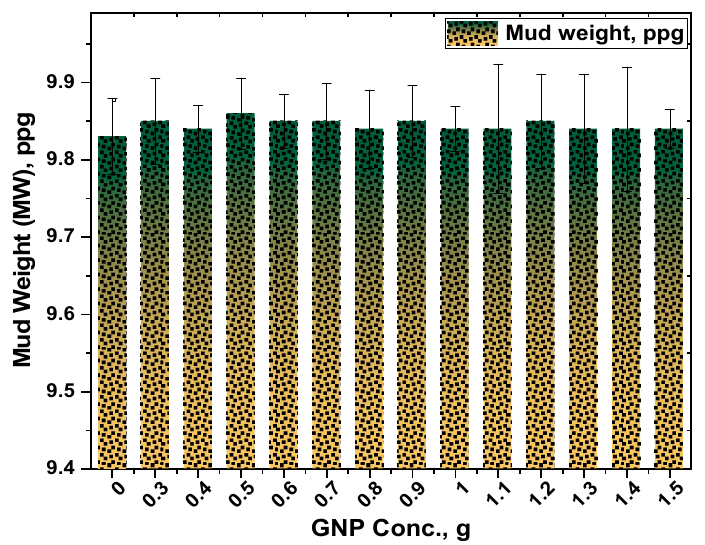
Figure 3. Response of GNP-Starch on the density of the formulated muds.